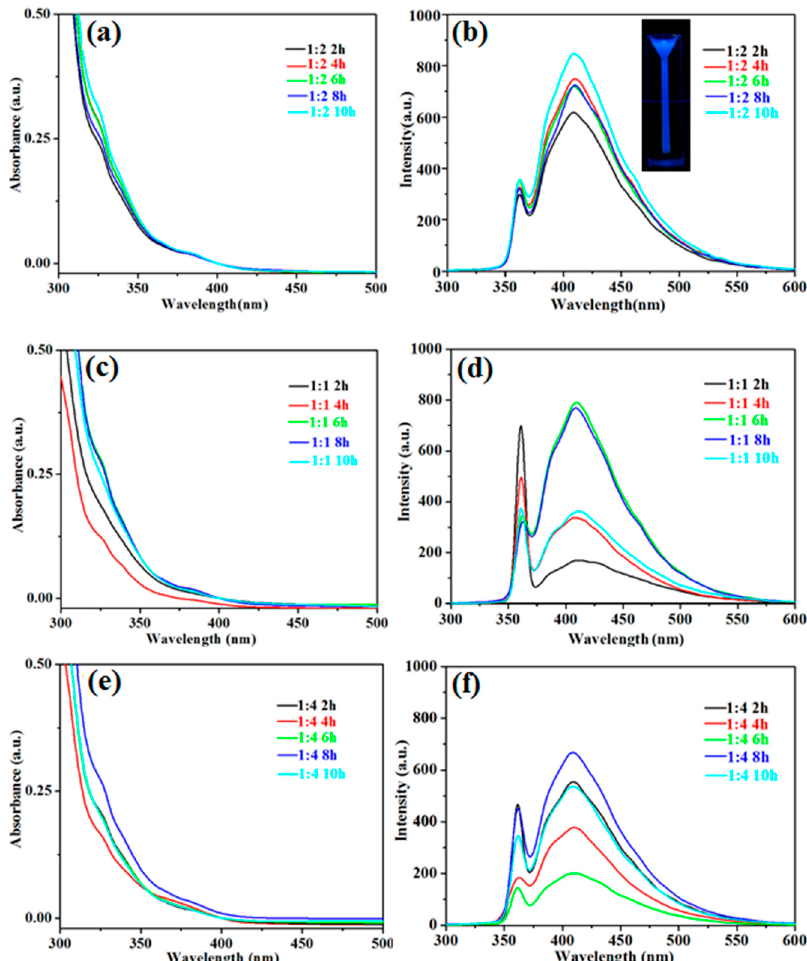
Figure 1. UV-Vis ( a , c , e ) and PL ( b , d , f ) spectra of ZnO QDs synthesized under different [Zn 2+ ]/[OH − ] molar ratios (( a , b ) 1:2, ( c , d ) 1:1, ( e , f ) 1:4) and various heating times (2, 4, 6, 8 and 10 h). Photoluminescence (PL) spectra were recorded with excitation at 360 nm. Inset photo of ZnO QDs was taken under UV light (365 nm).